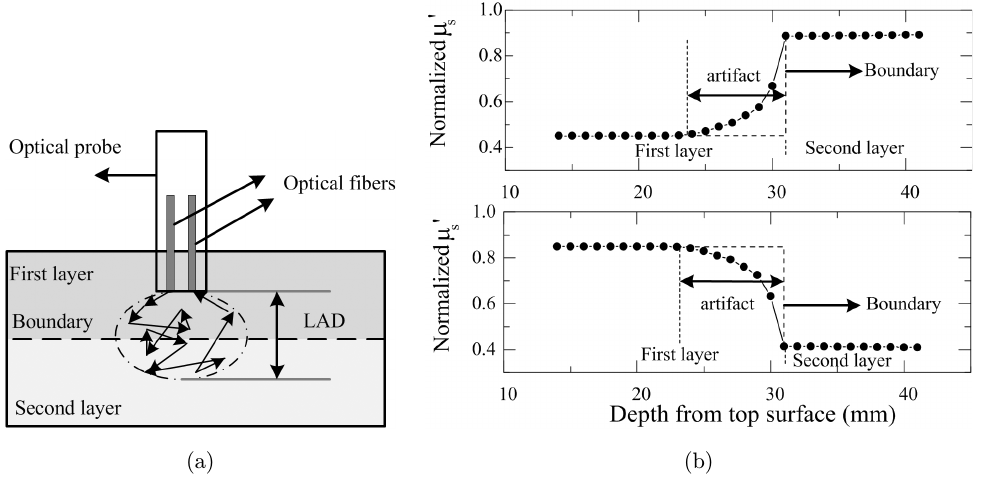
Fig. 1. Relationship between artifact and LAD. (a) Description of LAD (b) De¯nition of artifact by the curves of (cid:1) 0 s